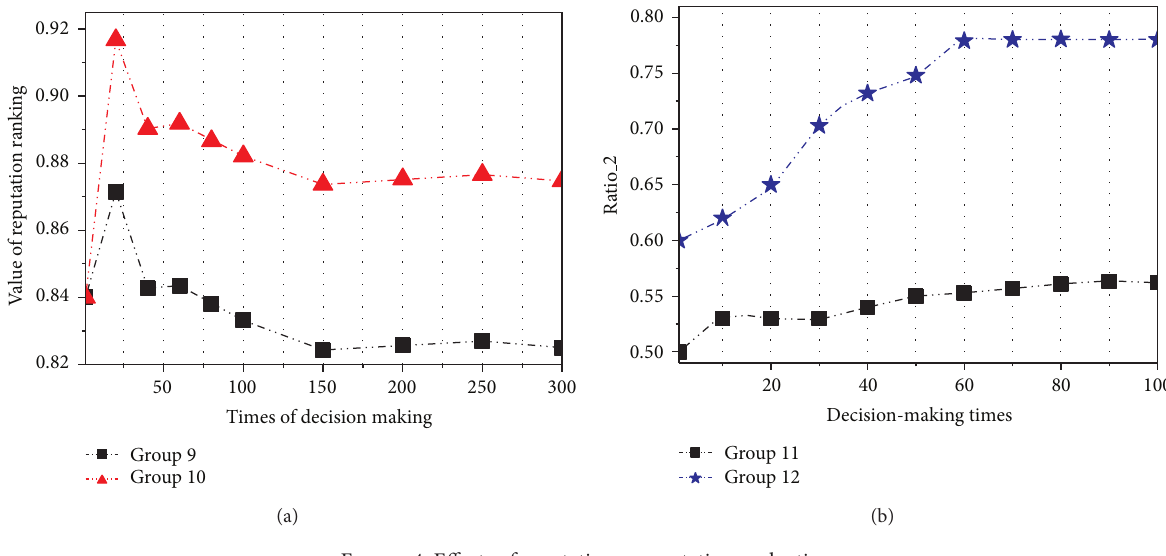
Figure 4: Effects of reputation computation